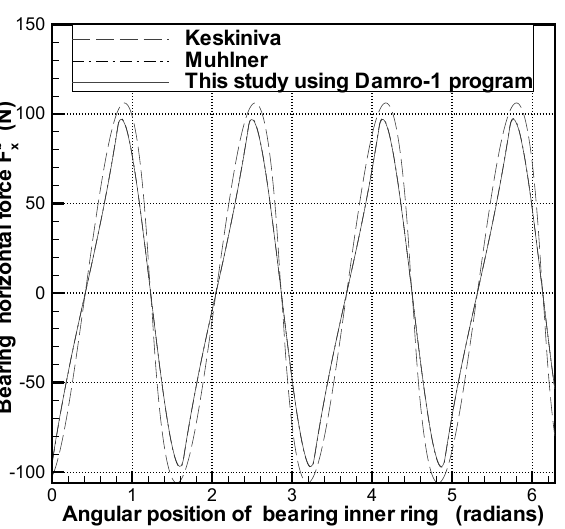
Fig. 6. Bearing horizontal force F b x vs shaft rotation for Ω s = 400 rad/s and vertical displacement e y = − 0.061 mm; This study (solid line); Kiskiniva’s model [44] (dashed line); Muhlner’s model [8] (dash-dot